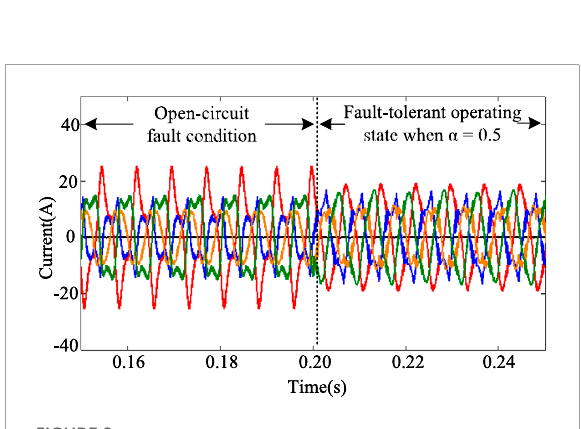
FIGURE 8 Current under the condition of motor fault and FT when α = 0 . 5.